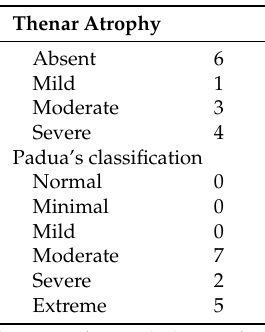
NCV, nerve conduction velocity; CTS, carpal tunnel syndrome. Table 3. Results of the number of hands at each Kapandji score. Kapandji Score